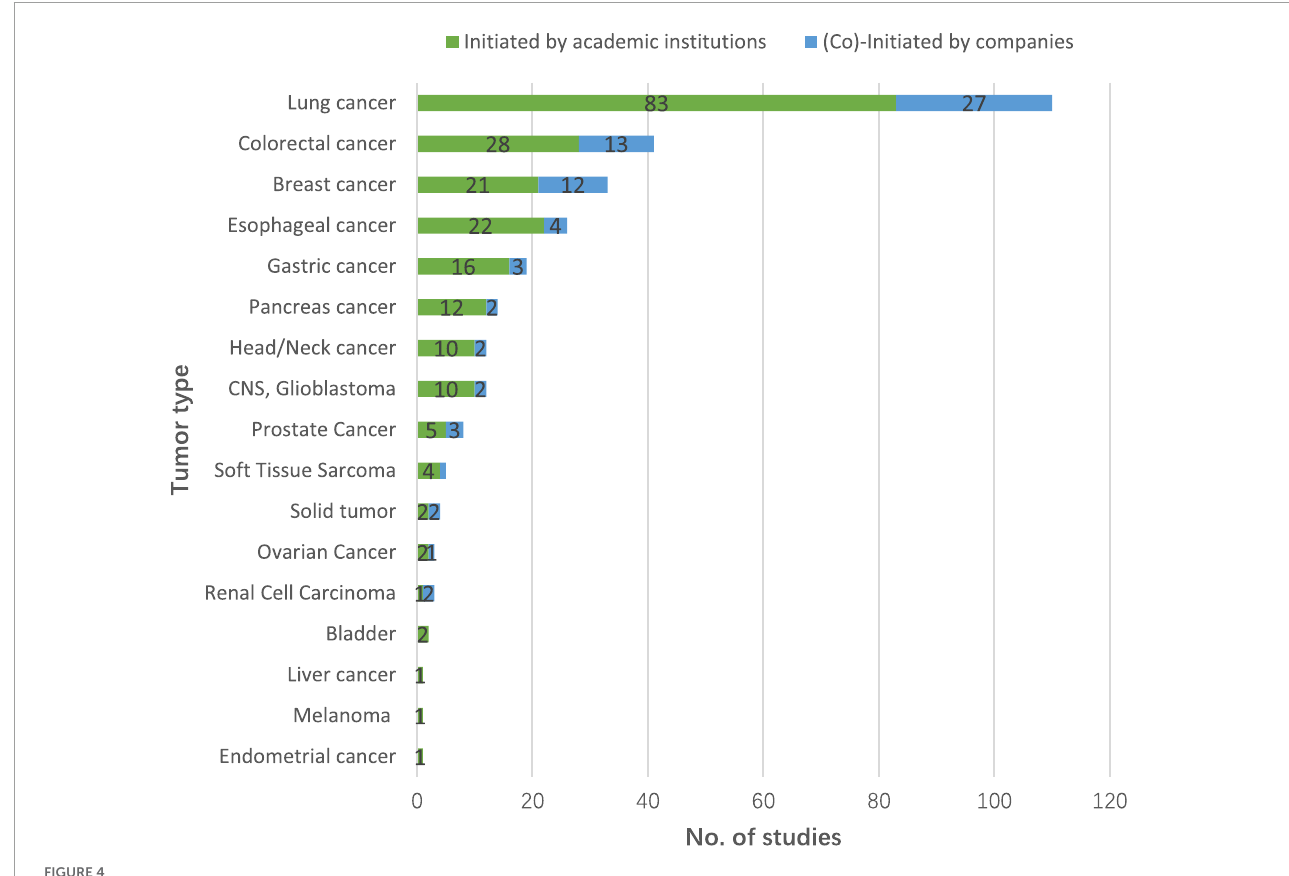
FIGURE4 Cancer type distribution of initiated geriatric drug trials on solid tumors,